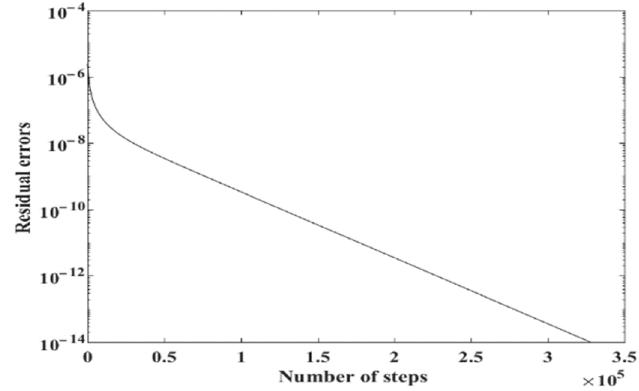
Figure 16. The convergence plot of Example 4.